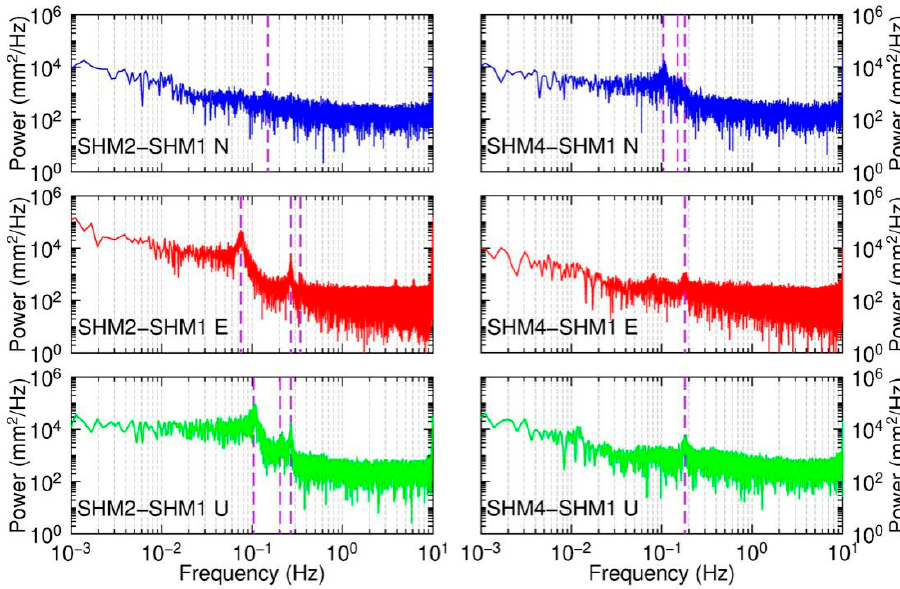
Figure 10. The spectrum analysis of vibrations of SHM2 and SHM4. The purple vertical dash lines indicate the locations of peak frequencies. Table 6. Peak frequencies extracted from Figure 10 (Hz).